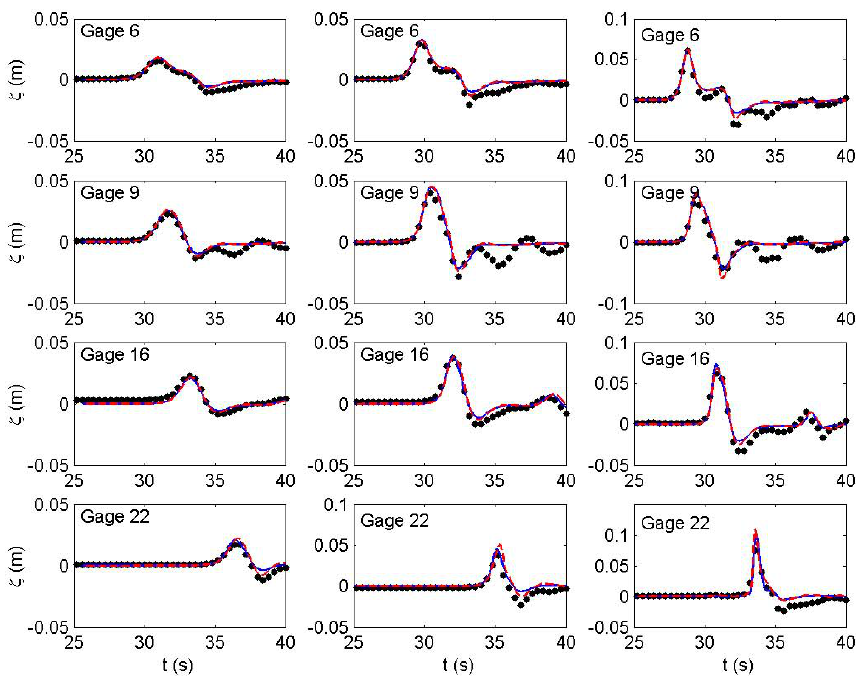
Fig. 12. Time series of water surface displacements in the experiments of solitary wave runup on conical island: measurements ( (cid:5) ), simula- tions in outer grid (—) and inner grid (- -). Initial wave heights are A/h =0.041, 0.088 and 0.181 in columns from left to right.